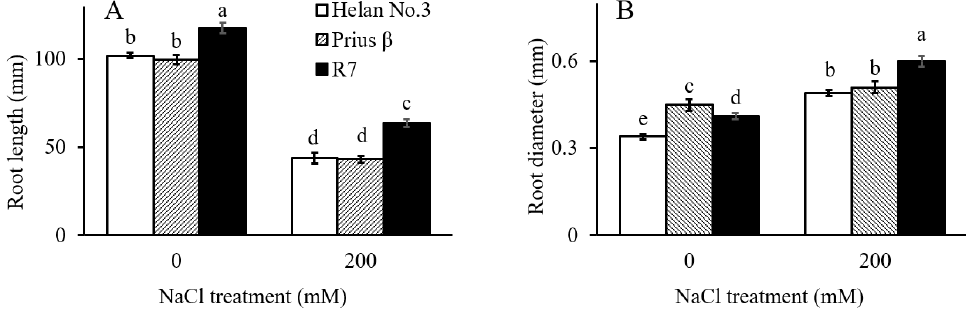
Figure 1. Final root length, relative root length ( A ) and root diameter ( B ) of Helan 3, Prius β and R7 in 0 and 200 NaCl treatments. Data are mean ± S.E. ( n = 6). Different letters indicate significant differences ( p <